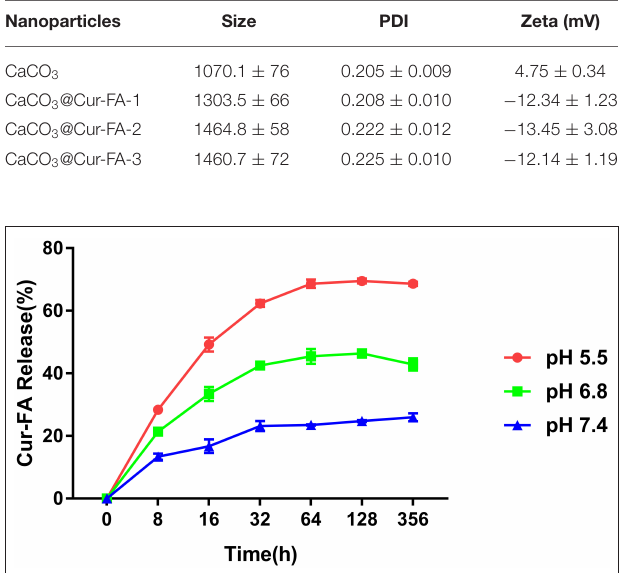
FIGURE 3 | Abilities of CaCO 3 and CaCO 3 @Cur-FA to scavenge DPPH (A) and ABTS + (B)